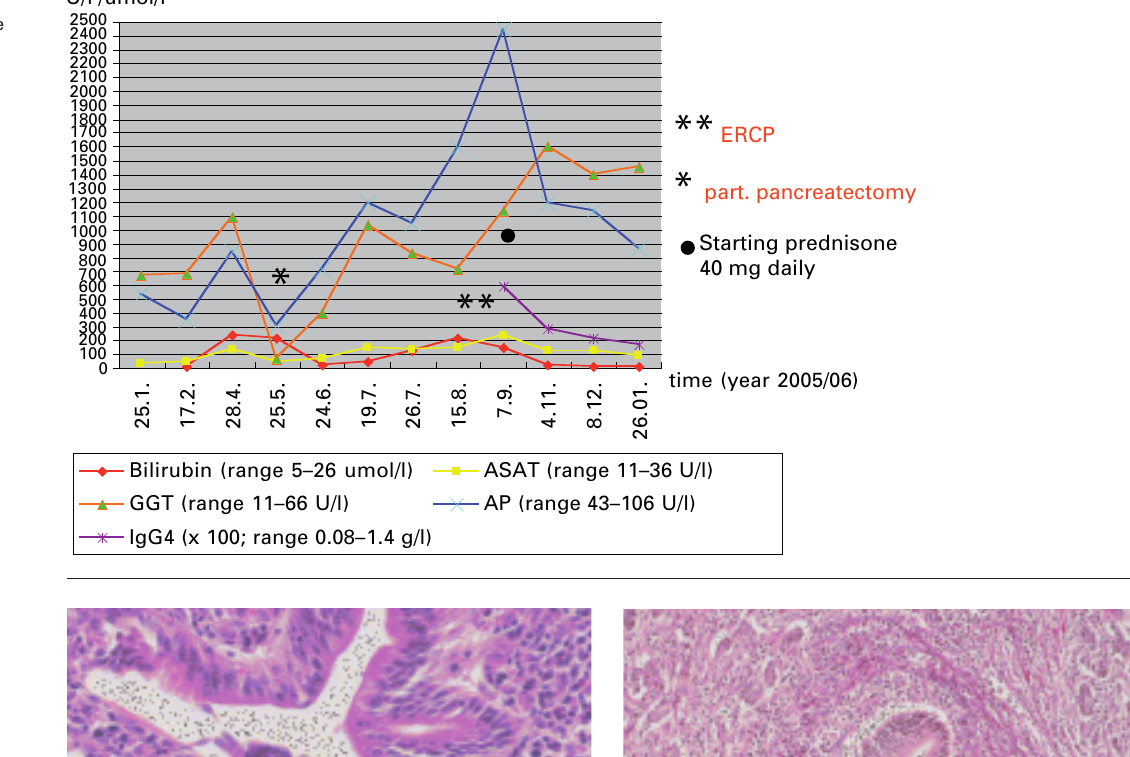
Figure 1 Fluctuations of the laboratory para-